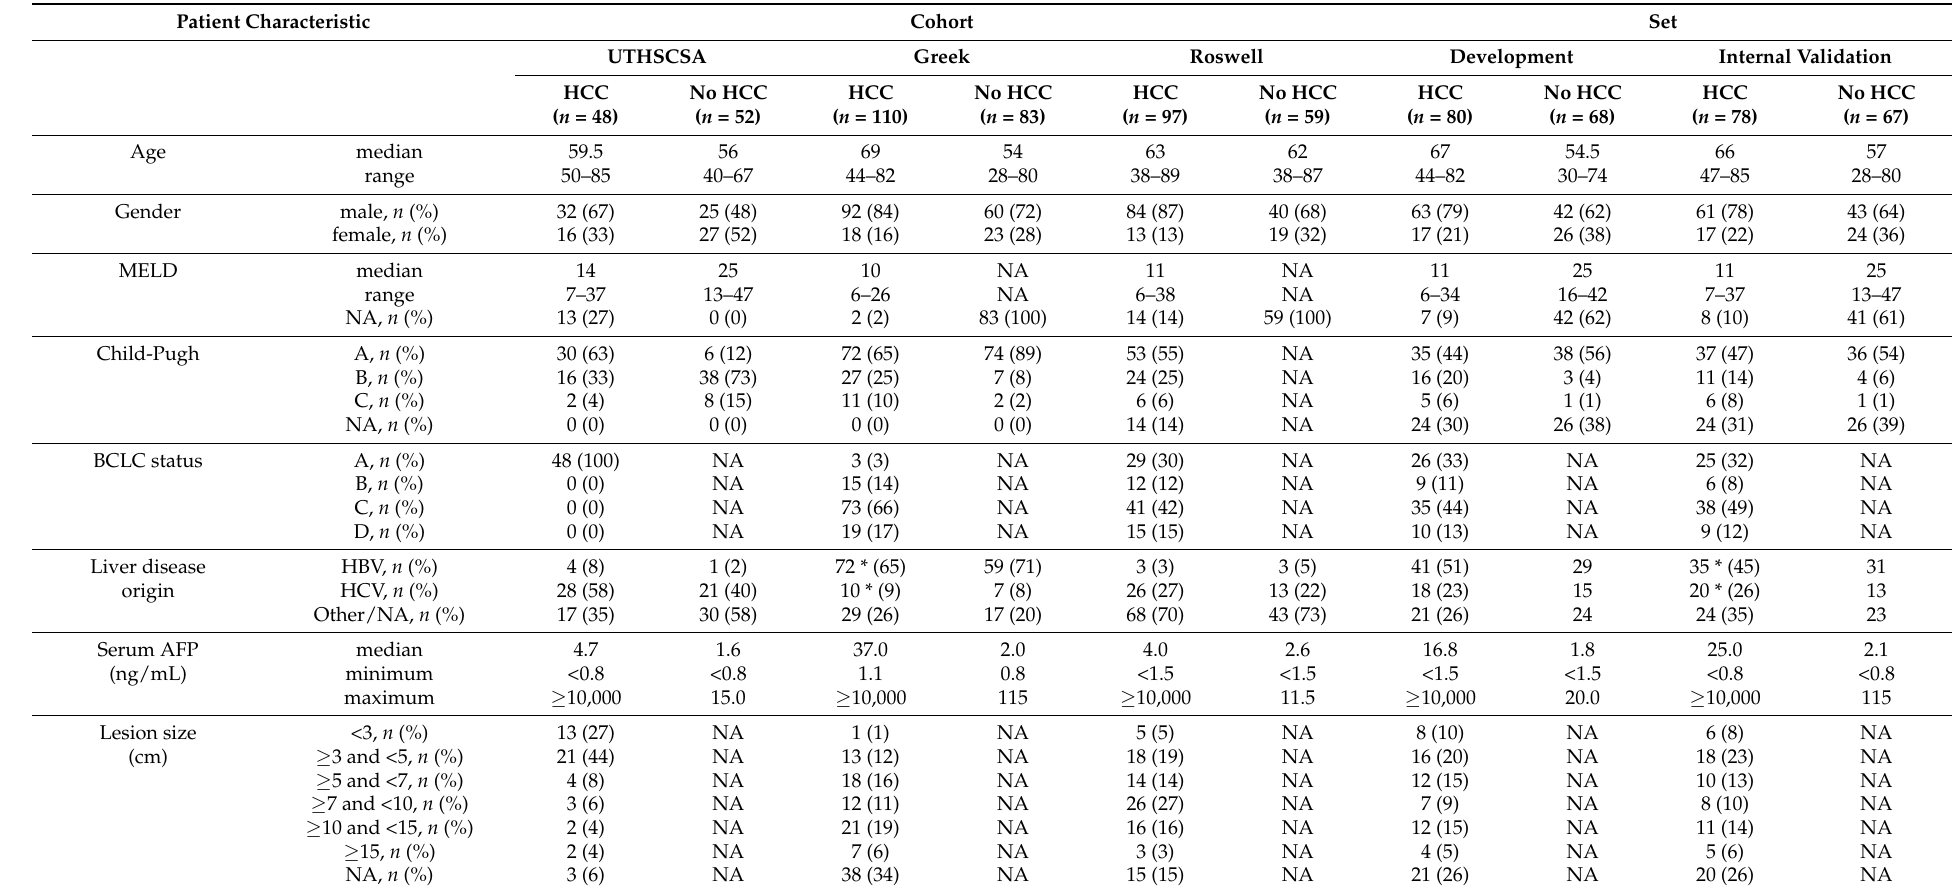
Table 1. Patient characteristics by cohort and